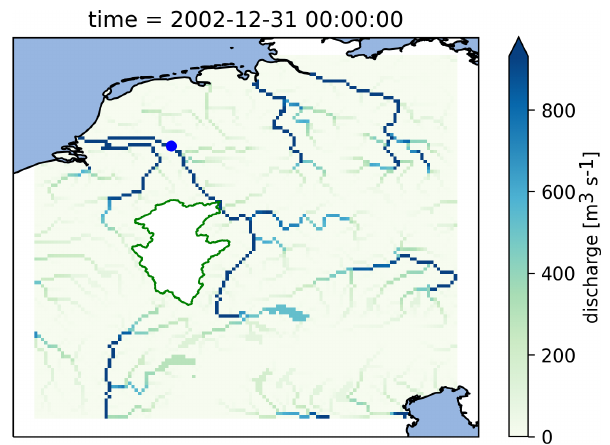
Figure 9. Calculated discharge in the Rhine basin at the end of the model run using the PCR-GlobWB 2.0 model for the Rhine coupled with the simplest one-bucket model from the MARRMoT suite of models for the Moselle subcatchment. The Moselle subcatchment has been cut out of the PCR-GlobWB 2.0 model (by altering its “landmask” setting). MARRMoT calculates the discharge for the Moselle, and at each time step this is added to the “channel storage” parameter of PCR-GlobWB 2.0 at the location where the Moselle flows into the Rhine (at Koblenz). The blue dot on the map indicates the location of the observation station at Lobith, which is used for the hydrographs shown in Fig.